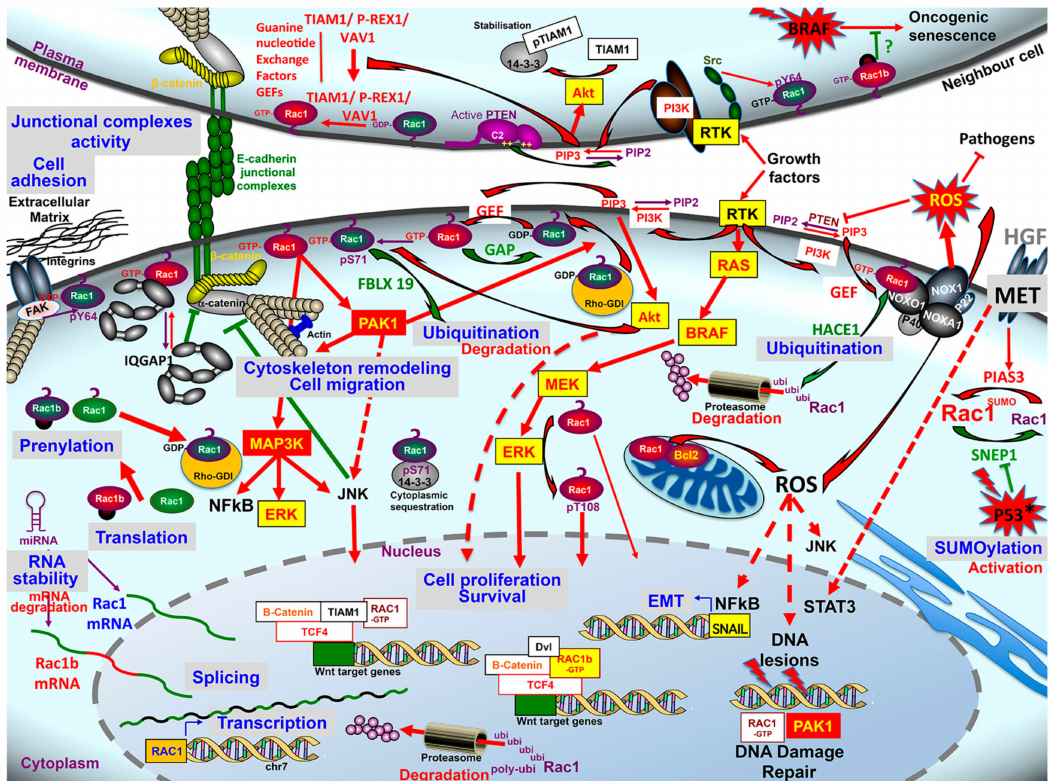
Figure 4. Schematic overview of Rac1 signaling dysregulation in colorectal cancer, at the levels of Rac1 itself (transcripts stability, splice variant, post-translational modifications), of its upstream regulators and interacting partners, of its downstream e ff ectors systems, and the biological impact of these dysregulations. For details see the